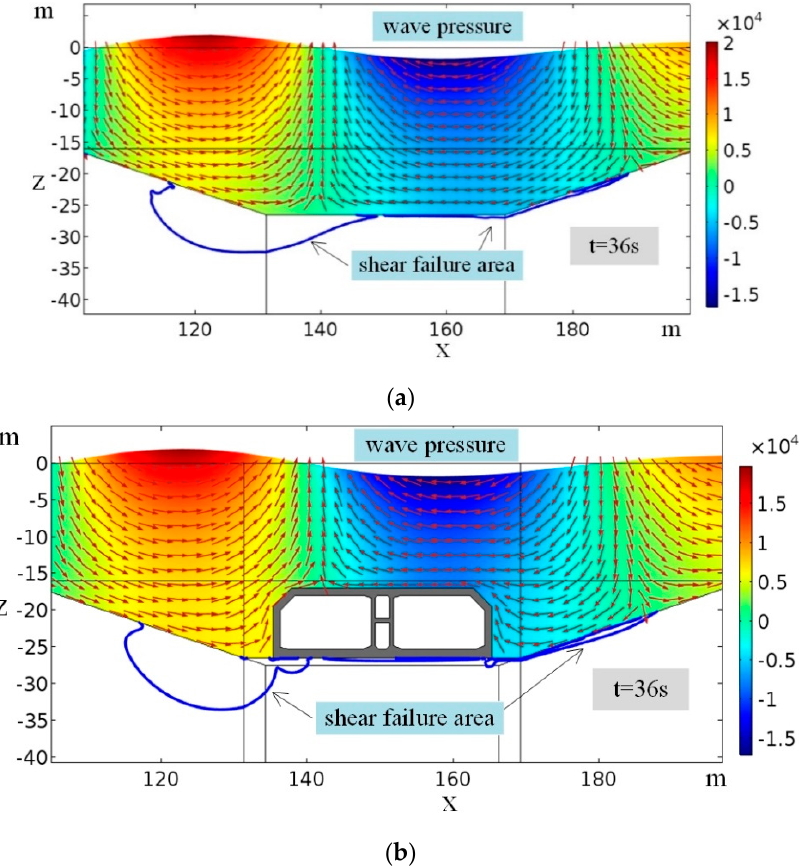
Figure 11. The shear failure area in the trench in two cases: ( a ) after the foundation groove is excavated ( t = 36 s) and ( b ) after the tunnel element is placed ( t = 36 s). ( t = 36 s) and ( b ) after the tunnel element is placed ( t = 36